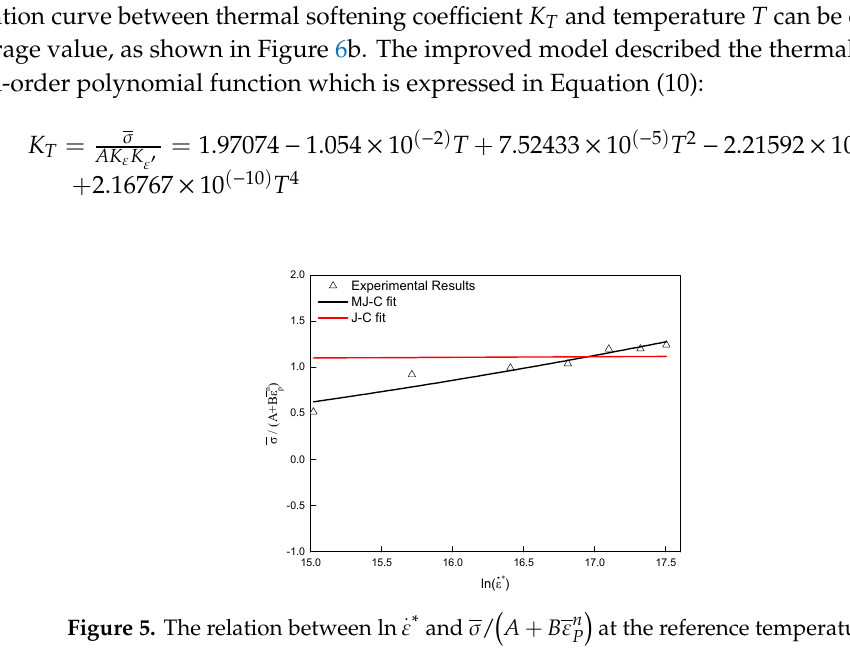
Figure 5. The relation between ln(cid:2013)(cid:4662) ∗ and (cid:2026)(cid:3364)/((cid:1827) + (cid:1828)(cid:2013)̅ (cid:3017)(cid:3041) ) at the reference temperature.